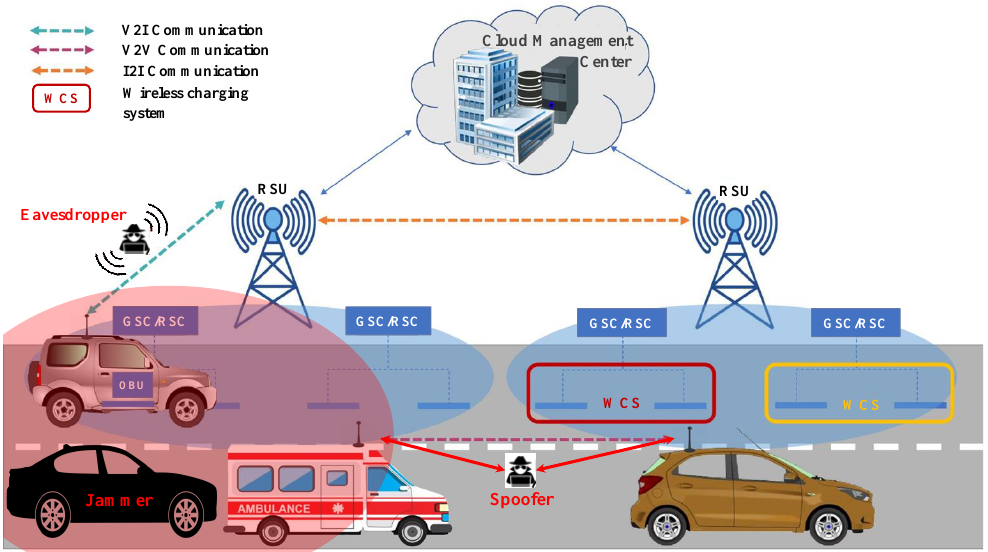
Figure 5. Overview of the different physical layer security threats in a vehicular communication